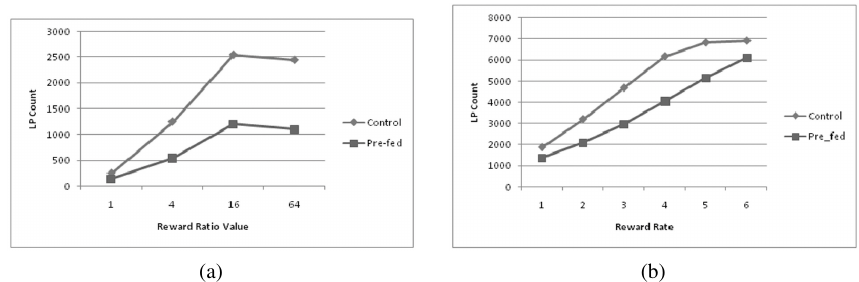
Figure 7. Experimental results showing an increasing trend of response rate for increasing the reinforcement ratio. (a) Behavioral results. (b) Neurocomputational model